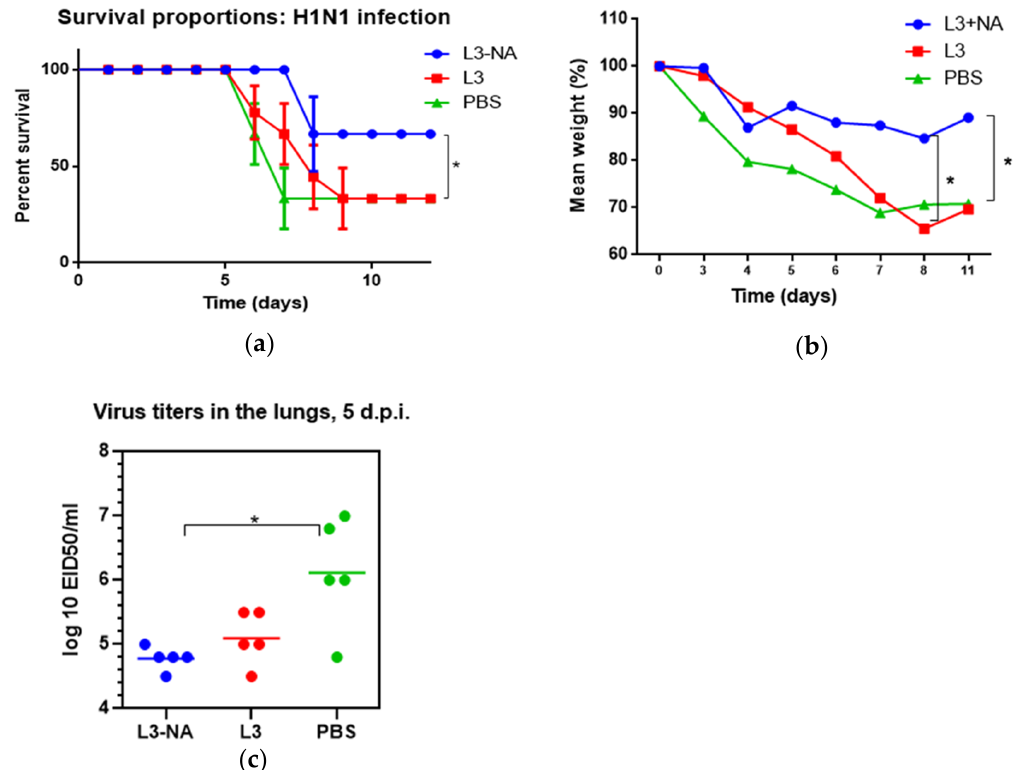
Figure 8. Protection against A/South Africa/3626/13(H1N1)pdm09 influenza infection; ( a ) survival proportions ( n = 9); ( b ) body weigh dynamics ( n = 12); ( c ) infectious virus isolation from the lungs ( n = 5). * p < 0.05.